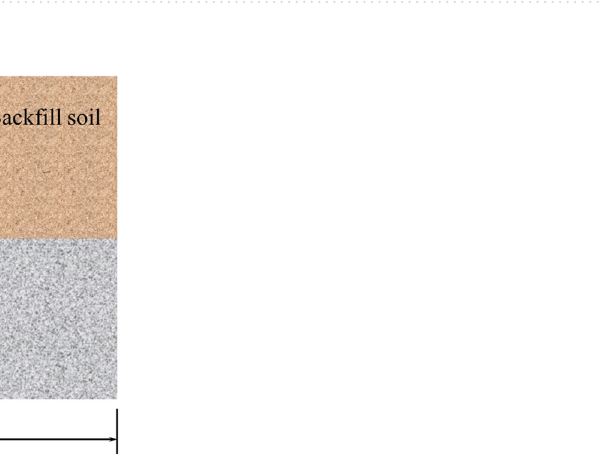
Figure 3. Finite element model and mesh detail.